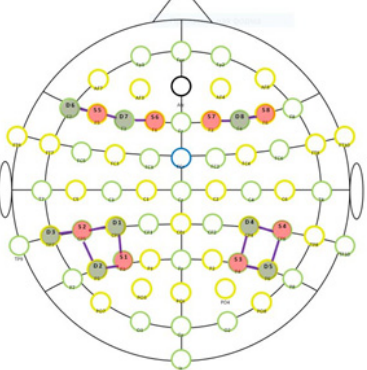
Figure 2. Probeset used for the fNIRS measurements indicating optode positions (red - source, green - detector) and channels that are formed by source-detector pair (violet